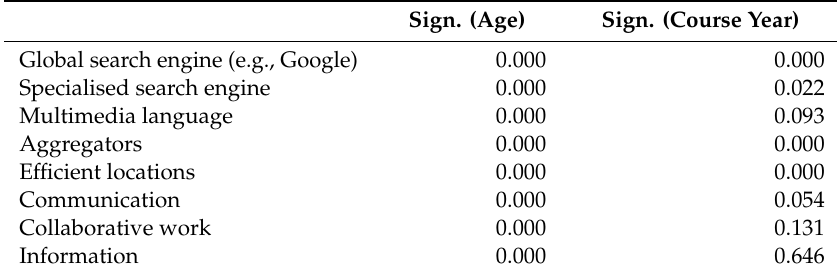
Table 6. ANOVA analysis.